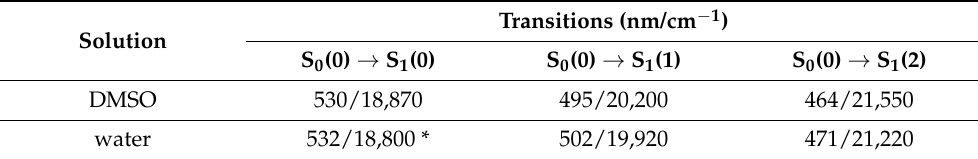
Table 1. Positions of electronic absorption band maxima for solutions of 2416SL.